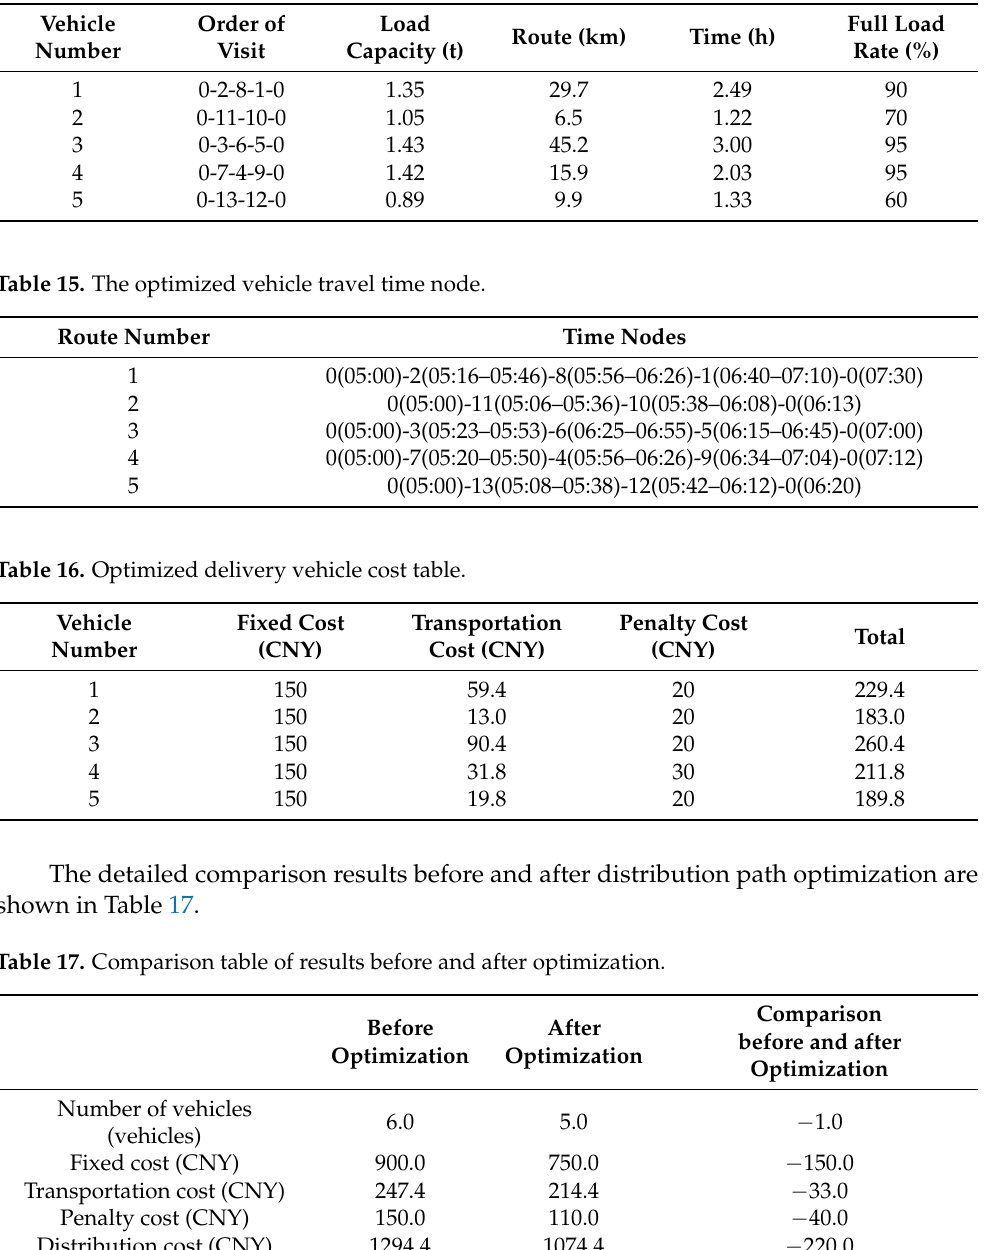
Table 14. List of optimized delivery vehicles.